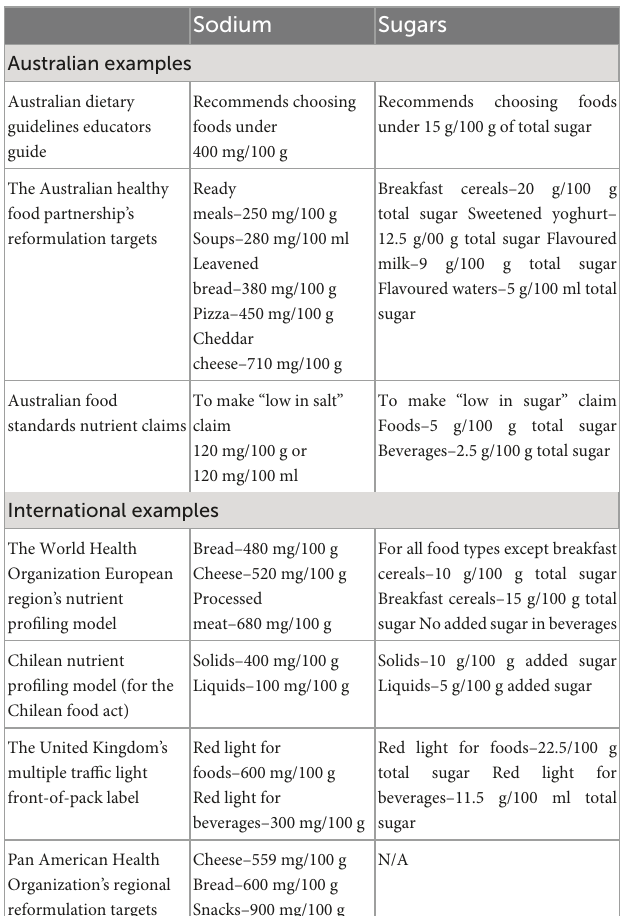
TABLE 1 Policy examples in Australia and internationally of sodium and sugar thresholds that were consulted to decide on pilot thresholds for model.